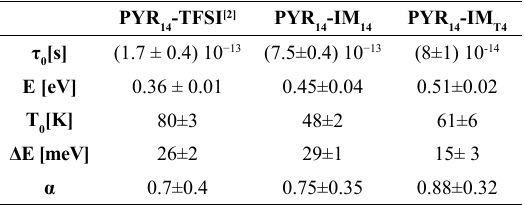
Table 1. Best fit parameters obtained for the relaxation processes. Superscript indicates the reference for the reported